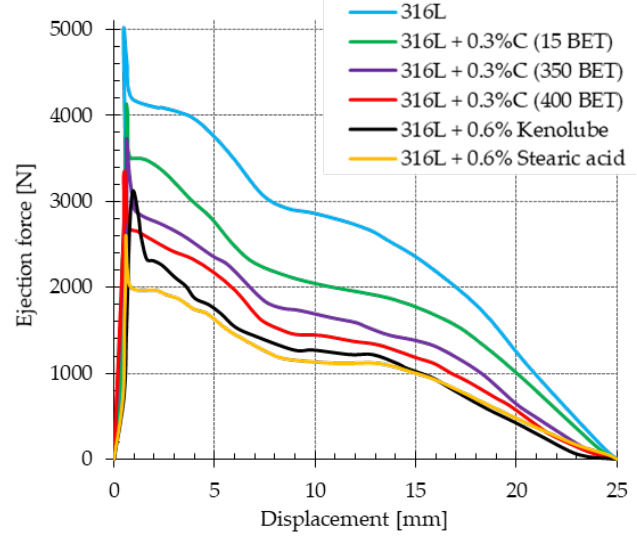
Figure 3. Dependence of the ejection force from the die as a function of the punch displacement for pure powder of AISI 316L austenitic stainless steel and mixtures of this powder with additives of graphite powders and lubricants.